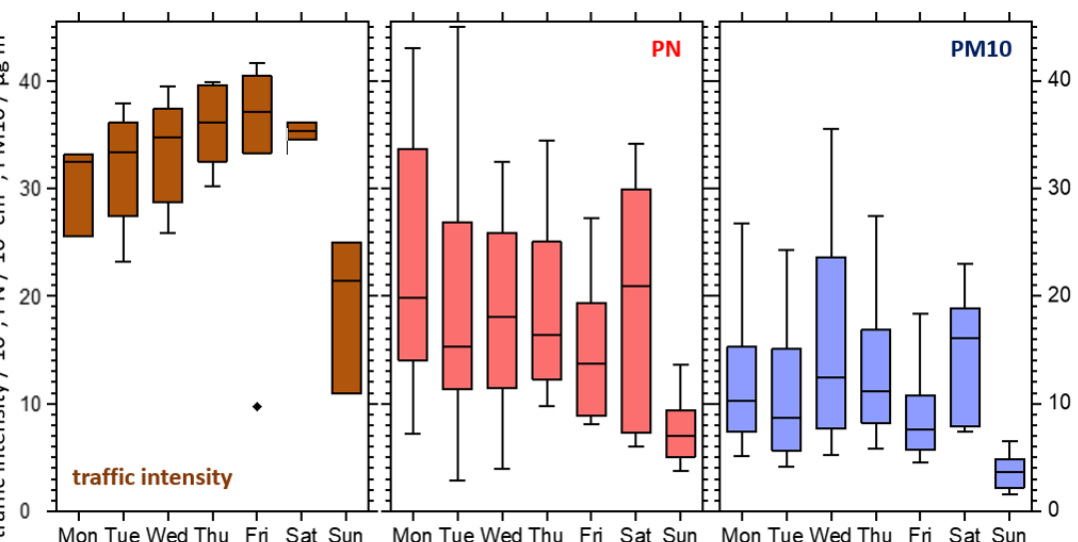
Figure 7. Box–whisker representations of traffic intensity (left panel; see caption of Figure 6 for details); measured PN (center panel) and measured PM10 concentrations (right panel) during the 40 rides. Here, data of high-traffic routes and low-traffic routes are combined. Boxes show interquartile ranges; medians are indicated by horizontal bars while whiskers show the 10–90% ranges. The outlier of traffic intensity of 9700 happened on 10 April 2020, which was a national holiday (Good Friday) that occurred during lockdown, ride 9.